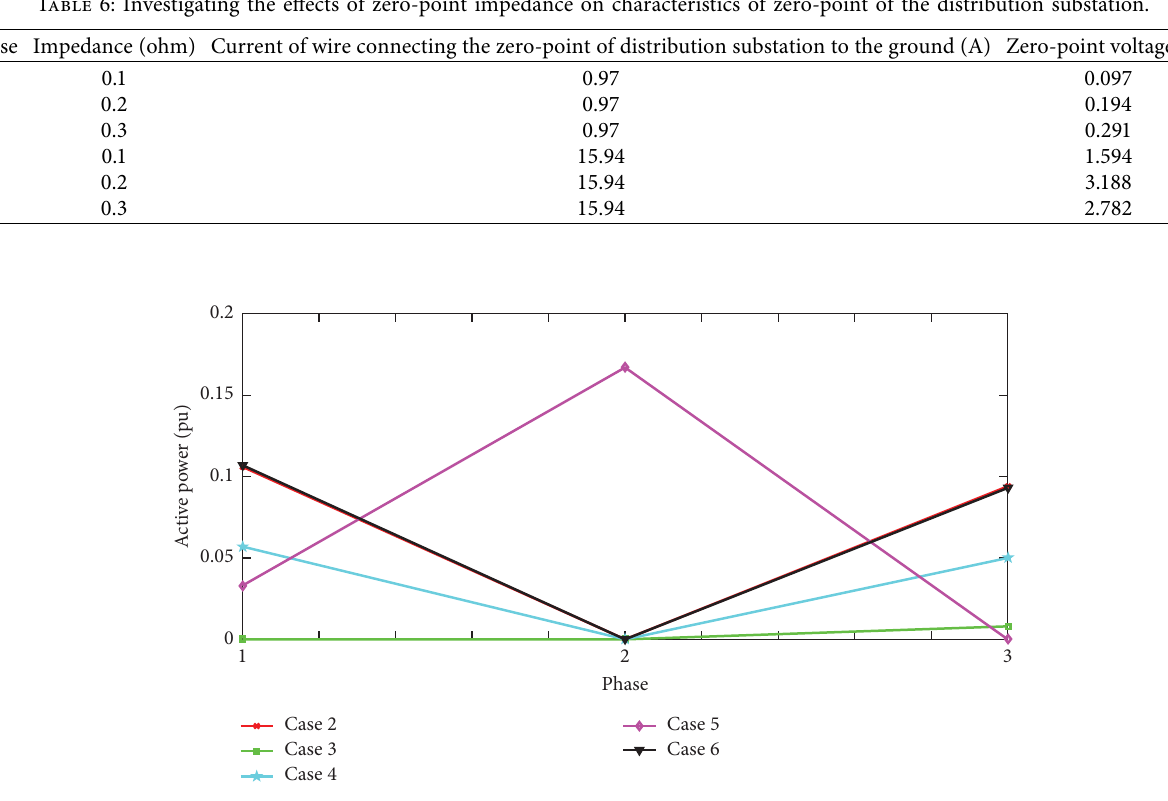
Figure 4: Te active power produced by each phase of the solar system in diferent case studies.